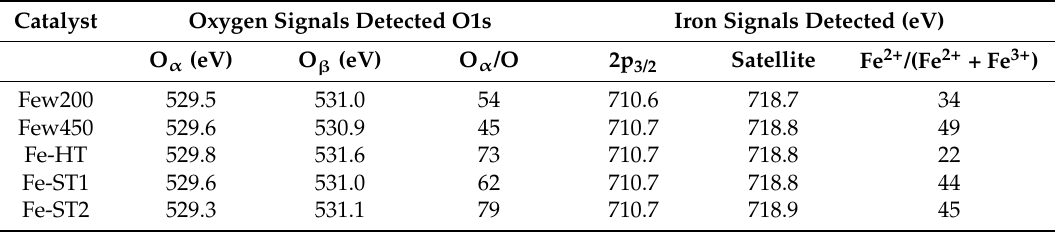
Figure 5. XPS spectra for the differently prepared FeOx catalysts. ( a ) O1s and ( b ) Fe 2p 1/2 and Fe 2p 3/2 . Table 3. X-ray photoelectron spectroscopy (XPS) results of the iron oxide catalysts synthesized (O α and Fe 2+ ratios given in